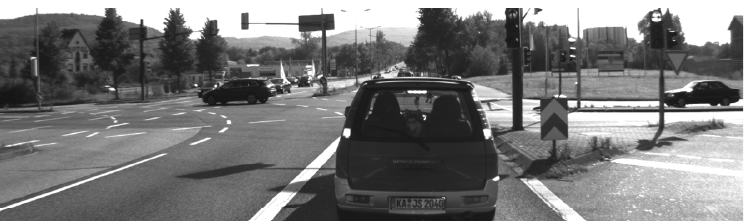
Figure 8. One test scenario of the Karlsruhe Institute of Technology (KIT) data set.